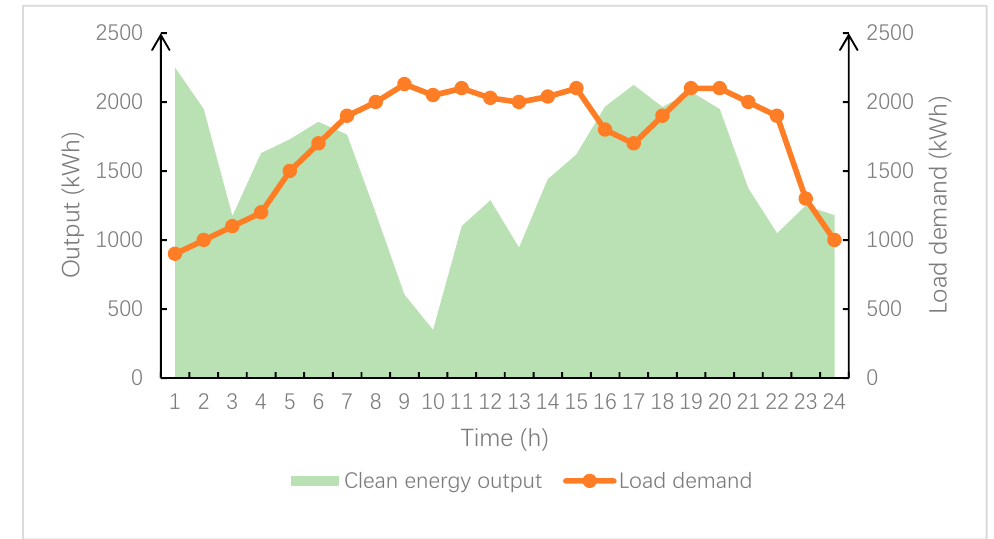
Figure 2. Power load demand of the park and output of clean energy units.